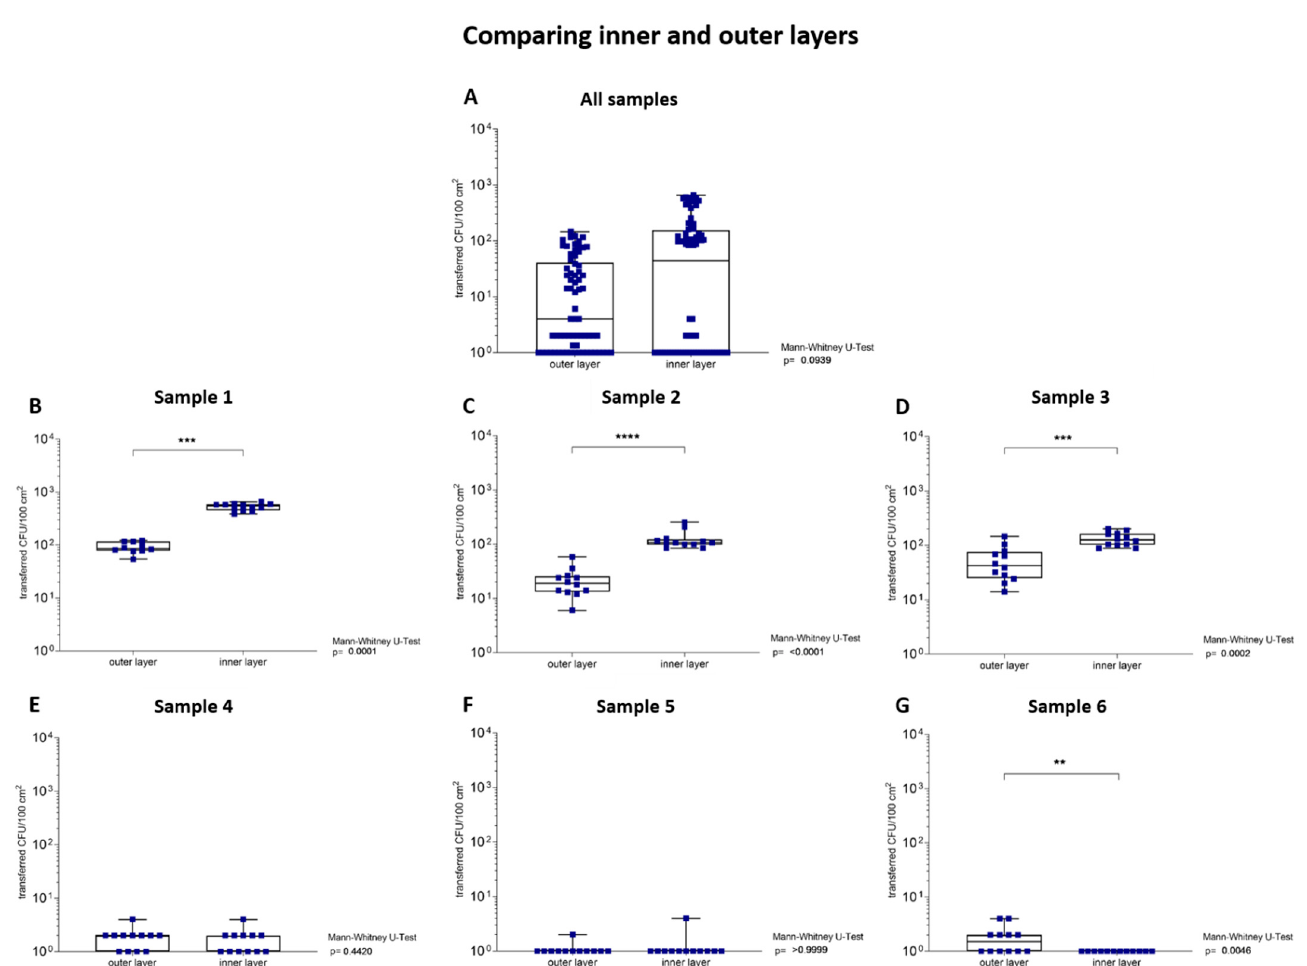
Figure 6. Significantly increased transfer of microorganisms from the inner layers of tested samples, compared to their outer layers. The nodes (blue) represent transferred microorganisms from the outer and inner layers of packaging material to TSA plates after the samples were loaded with 250 g for 5 min. The Mann–Whitney U test was used to measure whether there is a significant difference in the number transferred microorganisms between the outer and inner layers of the samples. A p -value of below 0.05 was defined as statistically significant. ( A ) The numbers of CFU/100 cm 2 transferred from the inner layers to the agar plates were not significantly ( p = 0.09) increased compared to the outer layers. ( B – D ) Samples with a high total CFU/100 cm 2 showed a significantly different transfer between outer and inner layers ( p < 0.01). ( E , F ) The evaluations revealed no significant microbial transfer ( p > 0.05) of samples 4 and 5. ( G ) Packaging materials 6 showed a significantly different transfer between outer and inner layers ( p = 0.01). ** Indicates statistical significance with a p -value below 0.01, *** indicates statistical significance with a p -value below 0.001 and **** indicates statistical significance with a p -value below 0.0001.